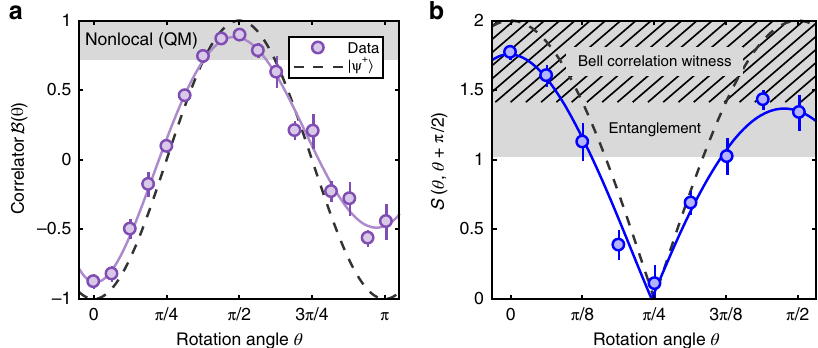
ffiffiffi p 2 (shaded region), signals the potential to observe the violation Fig. 4 Non-classical correlations in scattering halos. a A strong correlation B , exceeding 1 = of a Bell inequality based on a quantum mechanical model. The QM prediction of the violation was observed by Bð π = 2 Þ ¼ 0 : 90 ð 1 Þ with a signi fi cance of 18 σ from 18,000 experimental runs when the spins were rotated by π = 2. The dashed line is the theoretical prediction for the Bell triplet j Ψ þ i and the solid line is a guide to the eye, for both sub- fi gures. b Direct observation of non-classicality in the pair correlations based on the QM witness of Bell correlations S . Correlations lying in the shaded and hatched regions indicate the presence of quantum entanglement and Bell nonlocality, respectively. 6 σ violation of the Bell witness inequality (Eq. (6)) is observed by Sð 0 ; π = 2 Þ ¼ 1 : 77 ð 6 Þ . All error bars correspond to the standard error evaluated